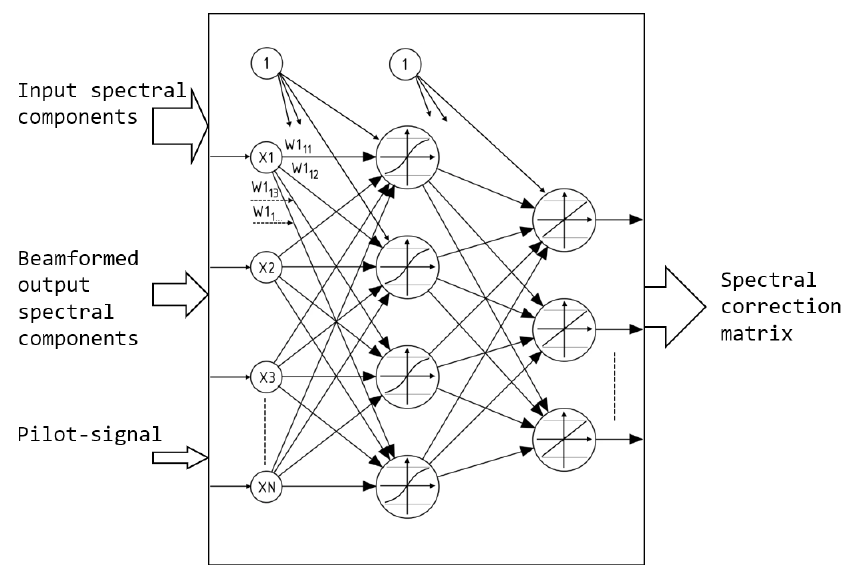
Fig. 3. Structure of neural network correction